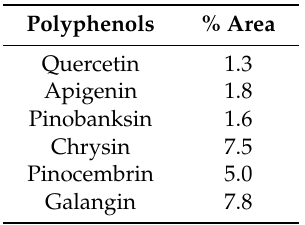
Table 1. The peak area for each polyphenol occurring in dry Multi Dinamic Extraction (M.E.D.) extract of brown propolis was identified through the mass